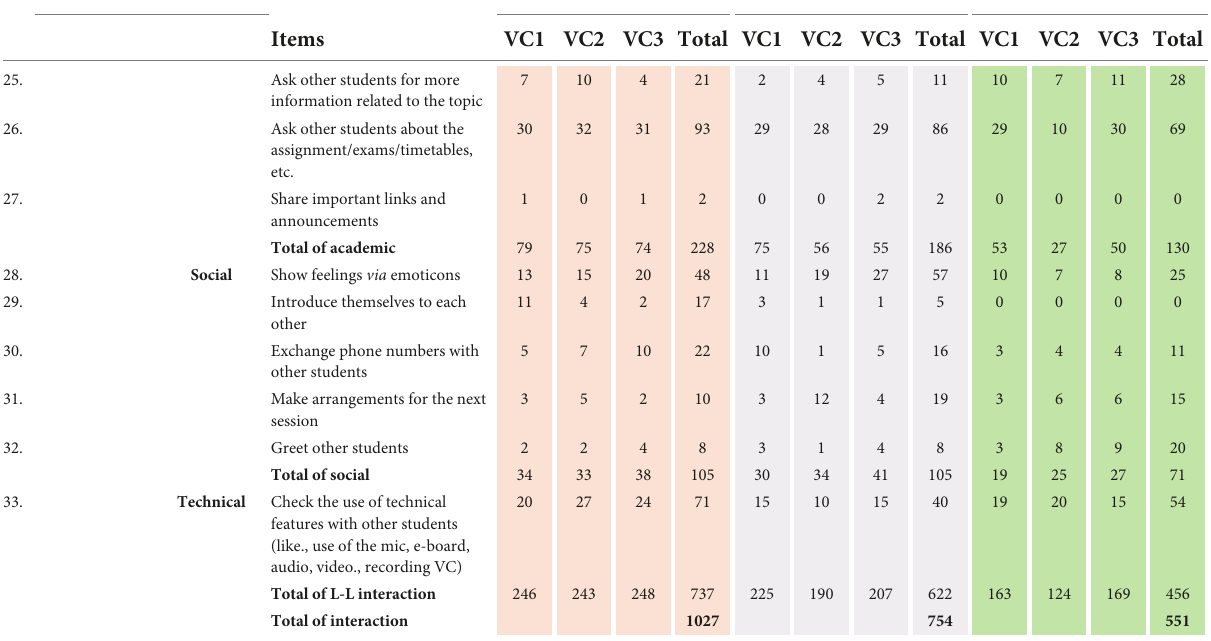
Discussion The study aims to determine the role of the text-chat feature and its impact on creating students’ SOVC in EFL VC. Data were collected from three sources, namely, archival data, interview, and questionnaire; the research questions were addressed and revealed how different text-based interactions in EFL VC promoted students’ SOVC. The results of the SOVC questionnaire demonstrated the strong role of the synchronous text interaction during EFL VC, and the questionnaire items had scores higher than M 3.5. Similarly, the results of